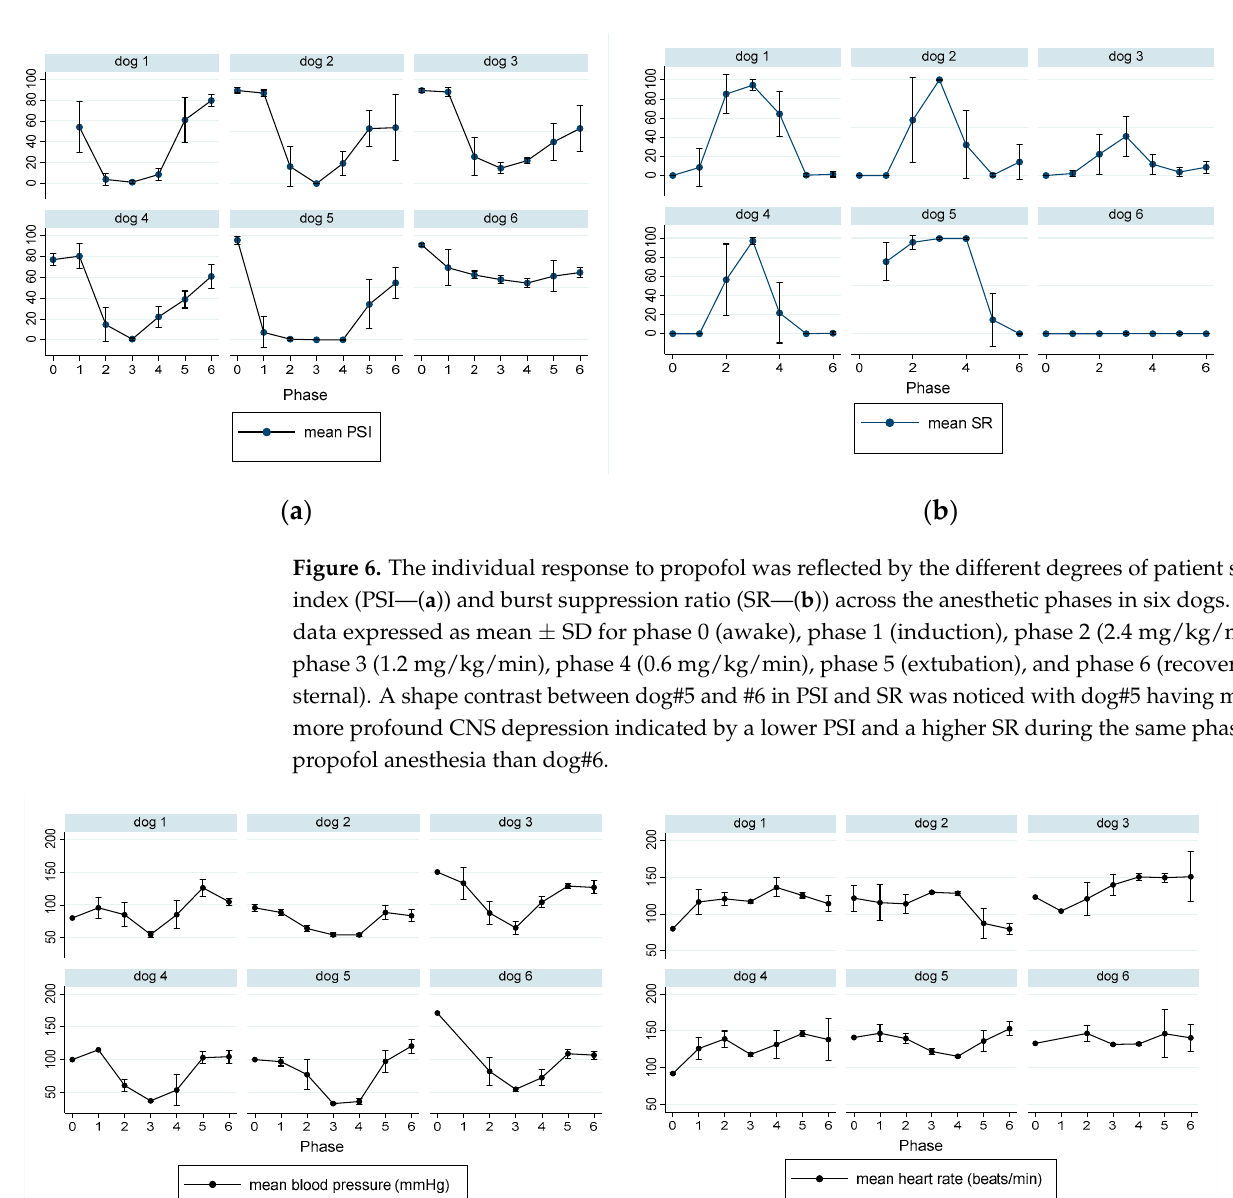
the dog through different phases of general anesthesia, and these brain state changes could be tracked closely with the use of raw EEG and EEG-processed indices together with traditional anesthesia monitoring techniques. Furthermore, the EEG indices can be used to differentiate the individual dog’s response to propofol during anesthesia. Propofol is one of the most frequently used general anesthetic drugs. It can be used as an induction anesthetic for endotracheal intubation, or anesthetic maintenance via in- termittent boluses or constant rate of infusion in dogs [31]. In clinical practice, propofol is frequently administered as a bolus to achieve rapid induction for endotracheal intubation in dogs [31]. The dose used for rapid sequence induction in healthy dogs without premed- ication is 6.0 ± 2.0 mg/kg [32]. In the current study, we chose to use a gradual induction with a 1 mg/kg/min constant rate of infusion based on our pilot study, which achieved a state that allowed us to track the potential EEG and brain state changes during the induc- tion. In a recent study, the optimal propofol infusion rate for endotracheal intubation that avoided postinduction apnea in healthy dogs was determined to be 1 mg/kg/min [33]. However, in that study, the dogs were premedicated with intramuscular dexmedetomi- dine (5 µg/kg) and methadone (0.5 mg/kg) 30 min before the gradual infusion of propofol started.